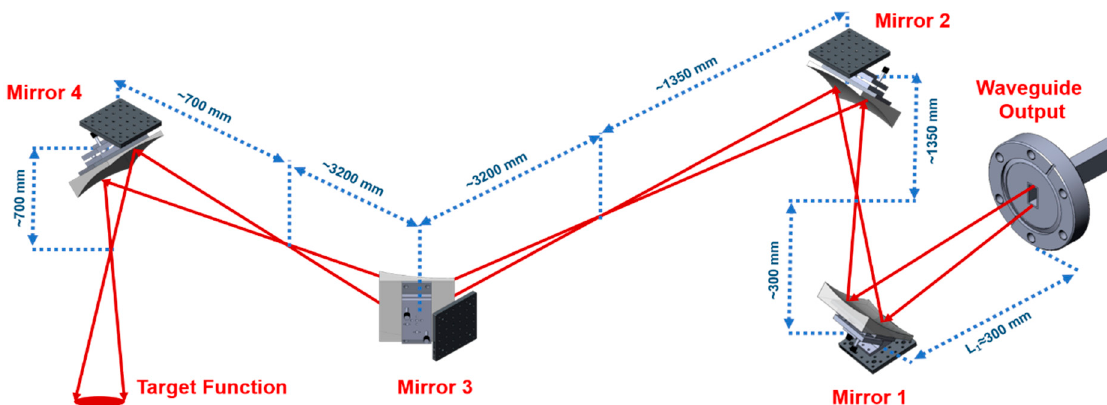
Figure 2. THz transmission line.